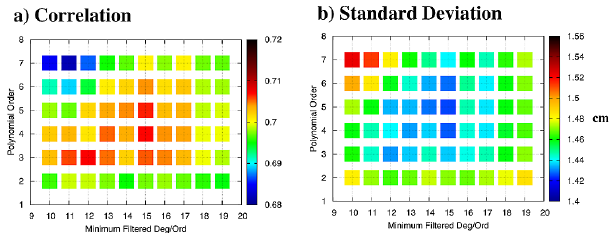
Fig. 11. Statistics comparing different destriping parameterizations with JPL ECCO: (a) correlation, and (b) standard deviation of residuals, both averaged over ocean grids.